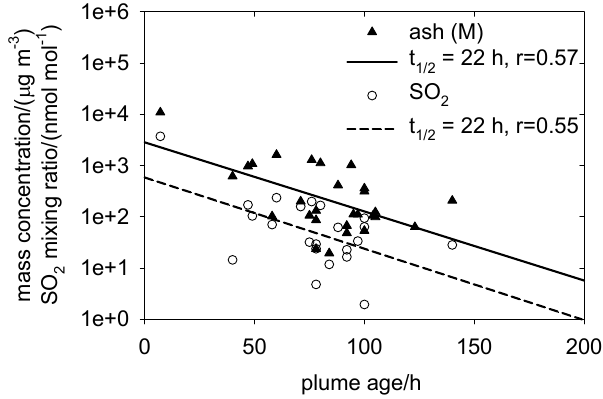
Fig. 27. Normalized (relative to maximum source strength) particle mass concentration (median case M) and SO 2 mixing ratio versus plume age. The legend identifies the half-value time t 1 / 2 and the correlation coefficients r of the linear